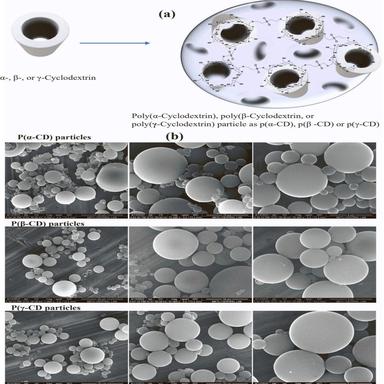
(a) The reaction schema of CD particle preparation from α-, β-, or γ-Cyclodextrin and (b) SEM images of poly(α-Cyclodextrin) (p(α-CD), poly(β-Cyclodextrin) (p(β-CD)), or pol(γ-Cyclodextrin) (p(γ-CD)) particles.